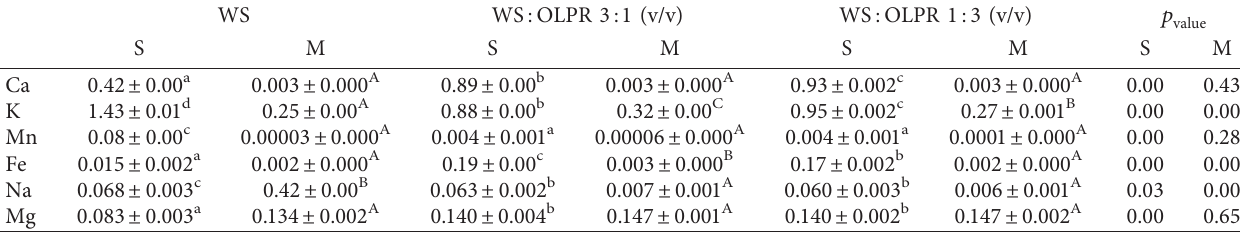
Table 5: Mineral composition (% dry weight) of substrates and mushrooms.